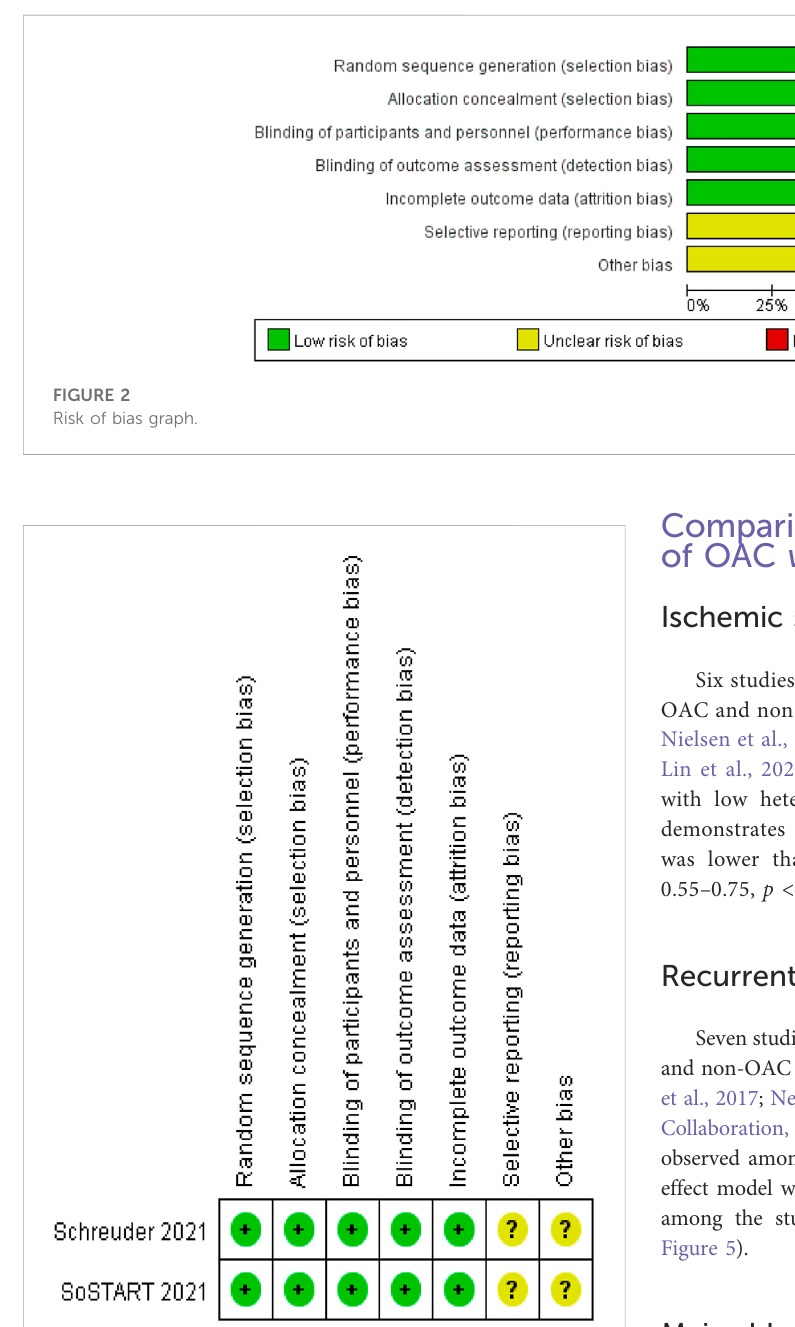
FIGURE 3 Risk of bias